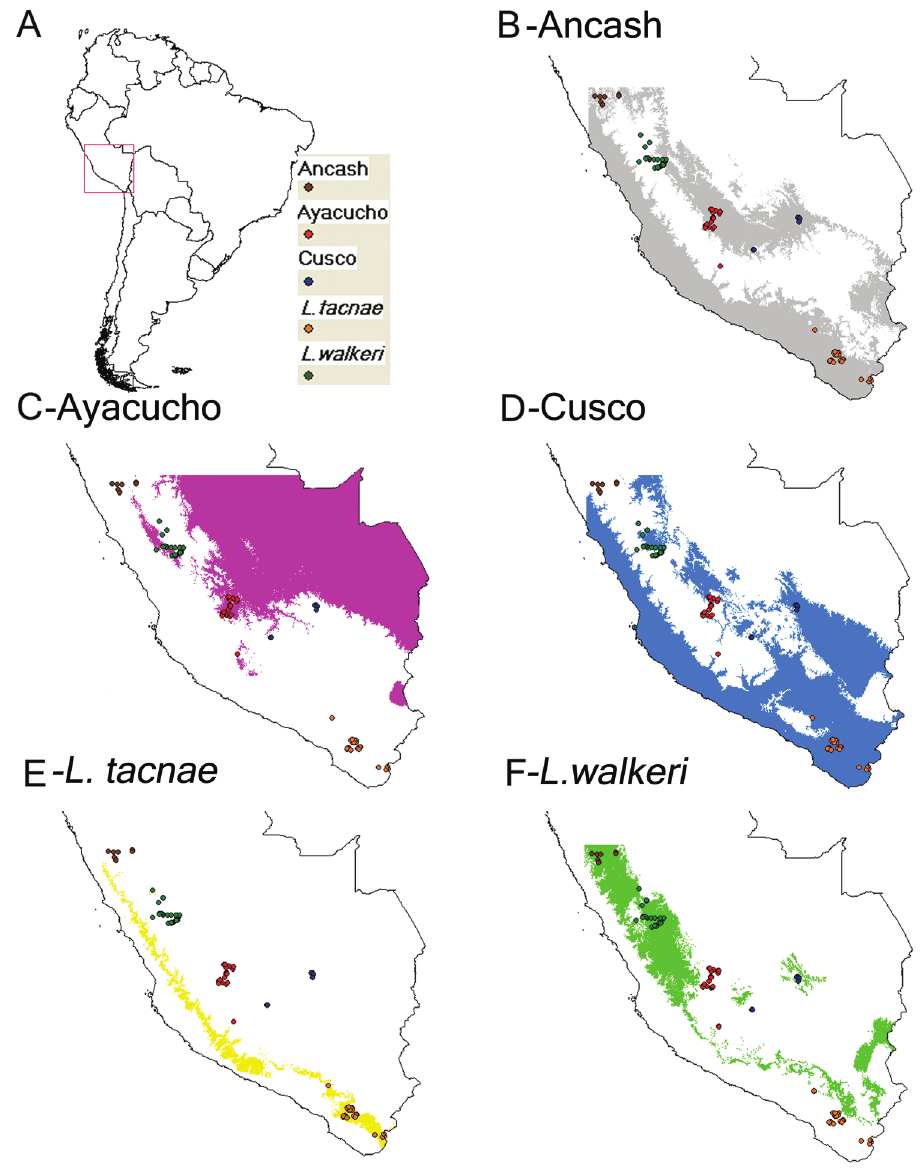
Figure 6. Predicted area and known geographic distribution ( a ) used to develop distributional models of Ancash ( B ) Ayacucho ( C ) Cusco ( D ) L. tacnae ( e ) and L. walkeri ( F